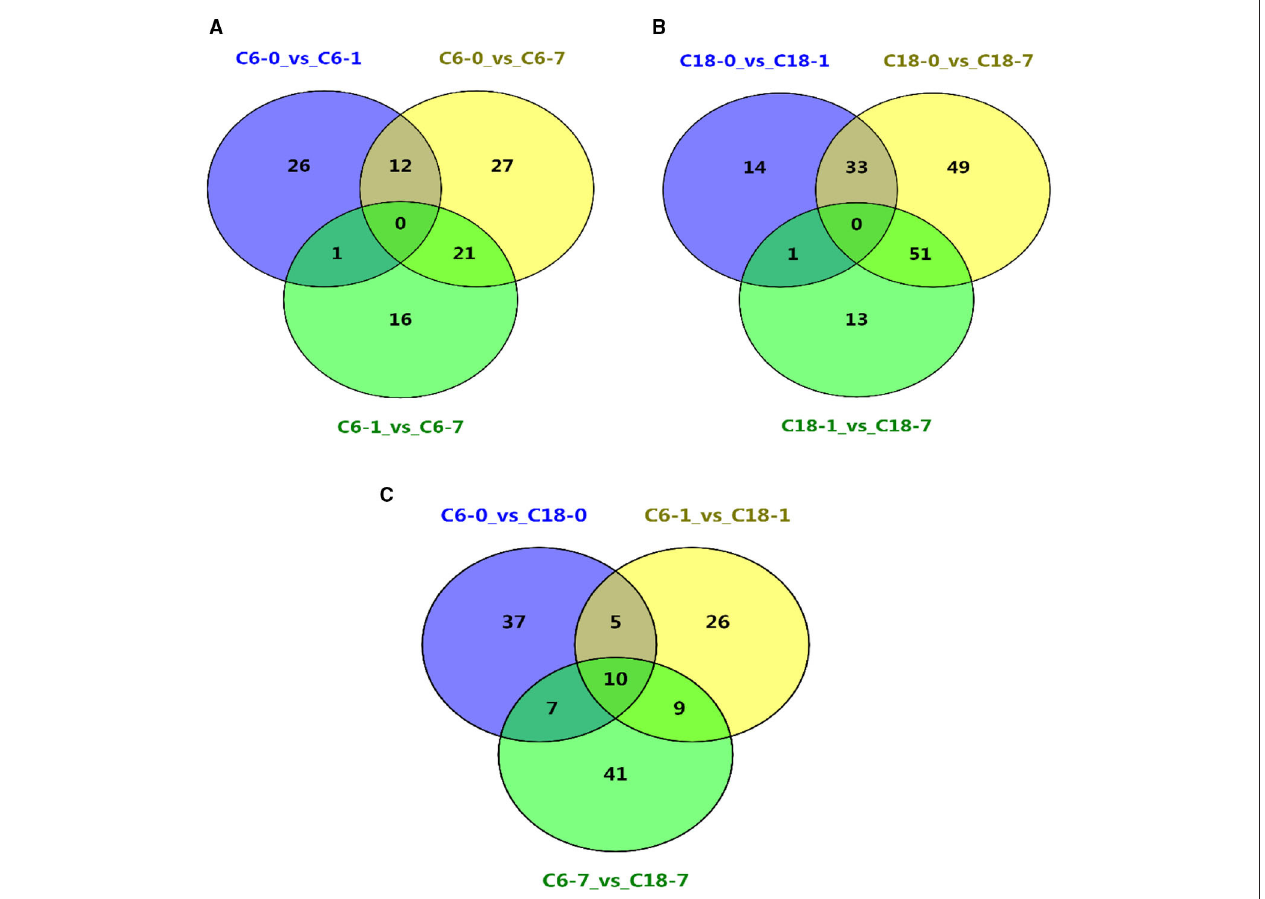
FIGURE 3 | Venn diagrams showing the shared and commonly known DAMs for all time points (A) between the different time points in C6; (B) between the different time points in C18; (C) between the same time points in C6 and